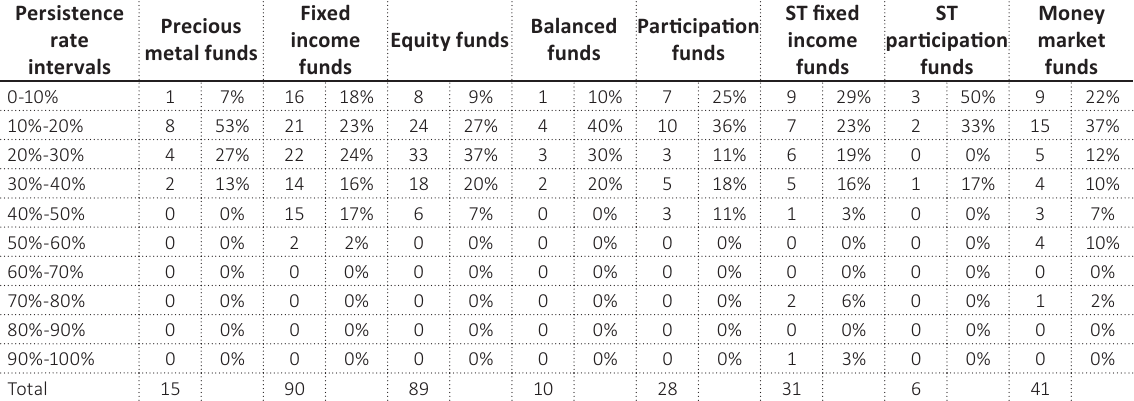
Table 5. Mutual funds persistent in performance